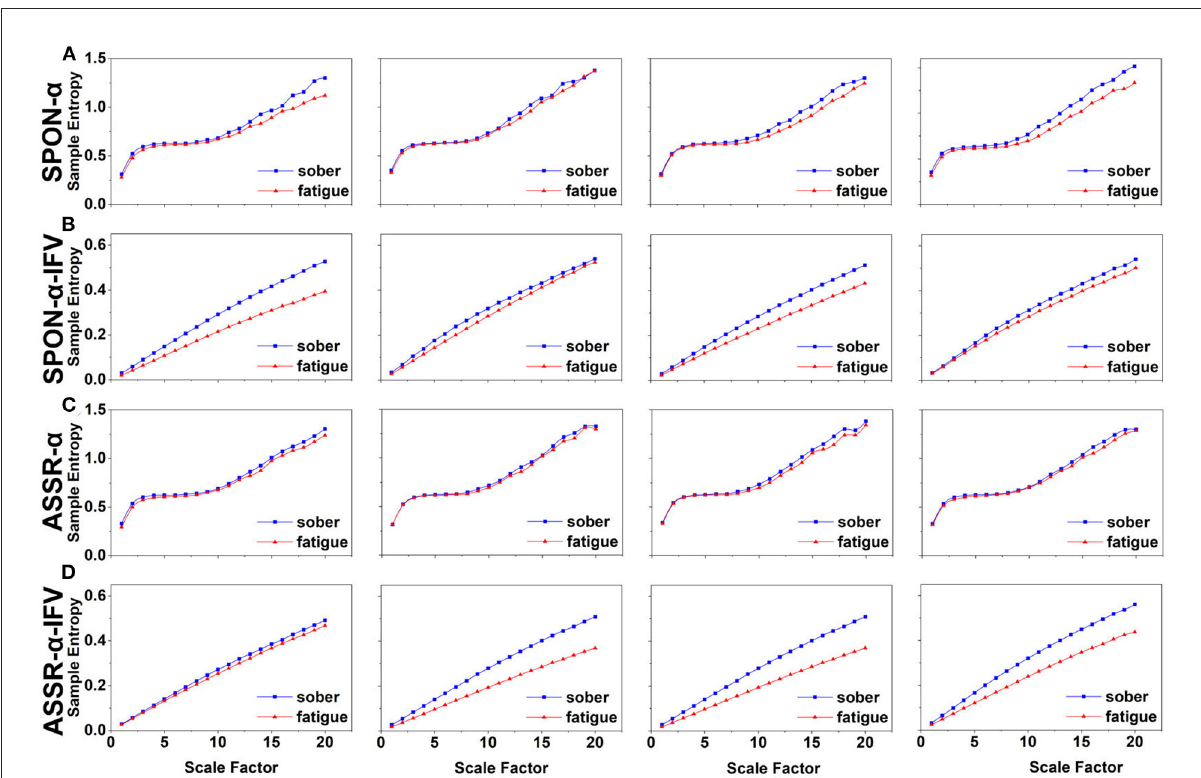
FIGURE4 MSE analysis of SPON- α (A) , ASSR- α (B) , SPON- α -IFV (C) , and ASSR- α -IFV (D) on temporal lobe (channel T4) from four exemplary subjects. The blue and red lines represent the Sober and MF states, respectively. See Section 2.5 for the definitions of